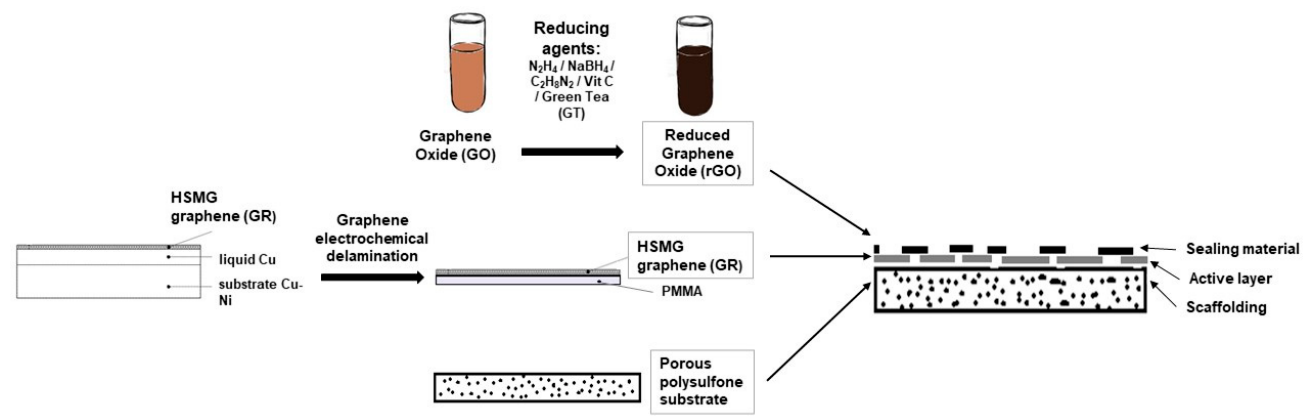
Figure 1. Graphene membrane preparation scheme.